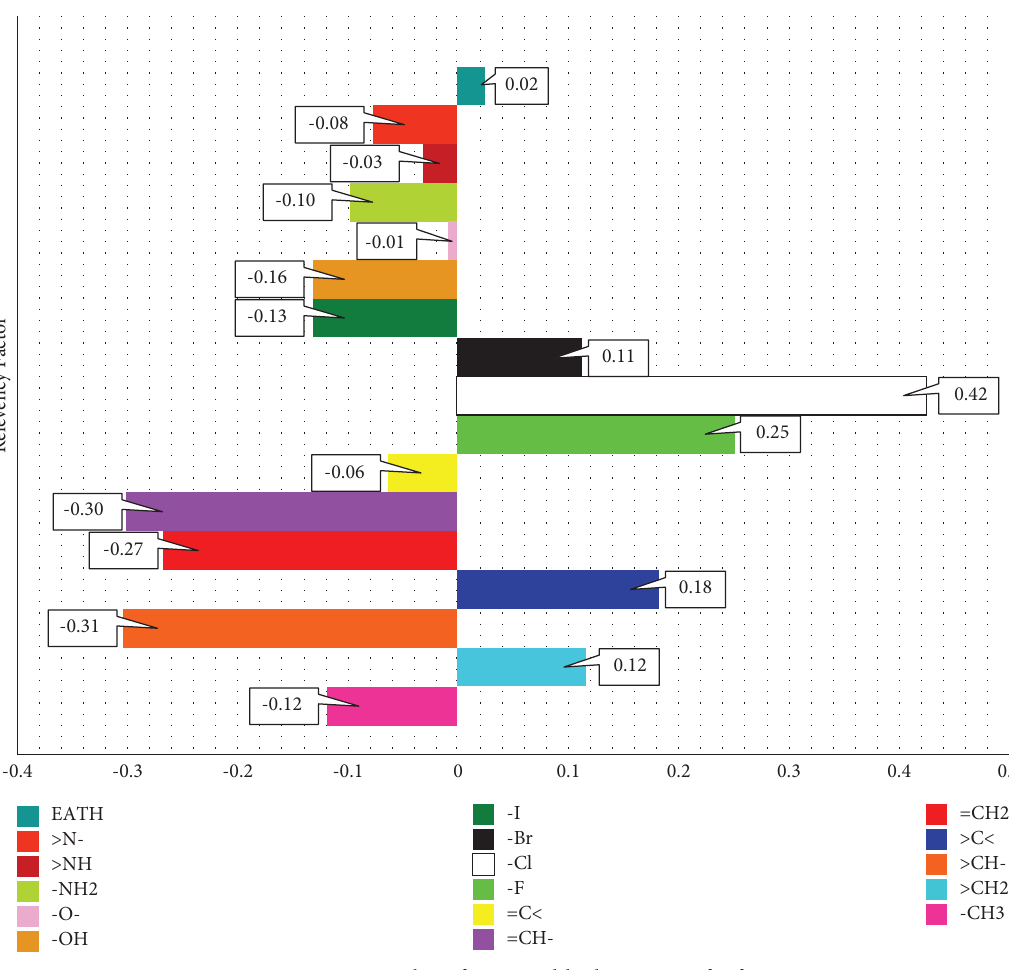
Figure 6: Sensitivity analysis for normal boiling point of refrigerants.